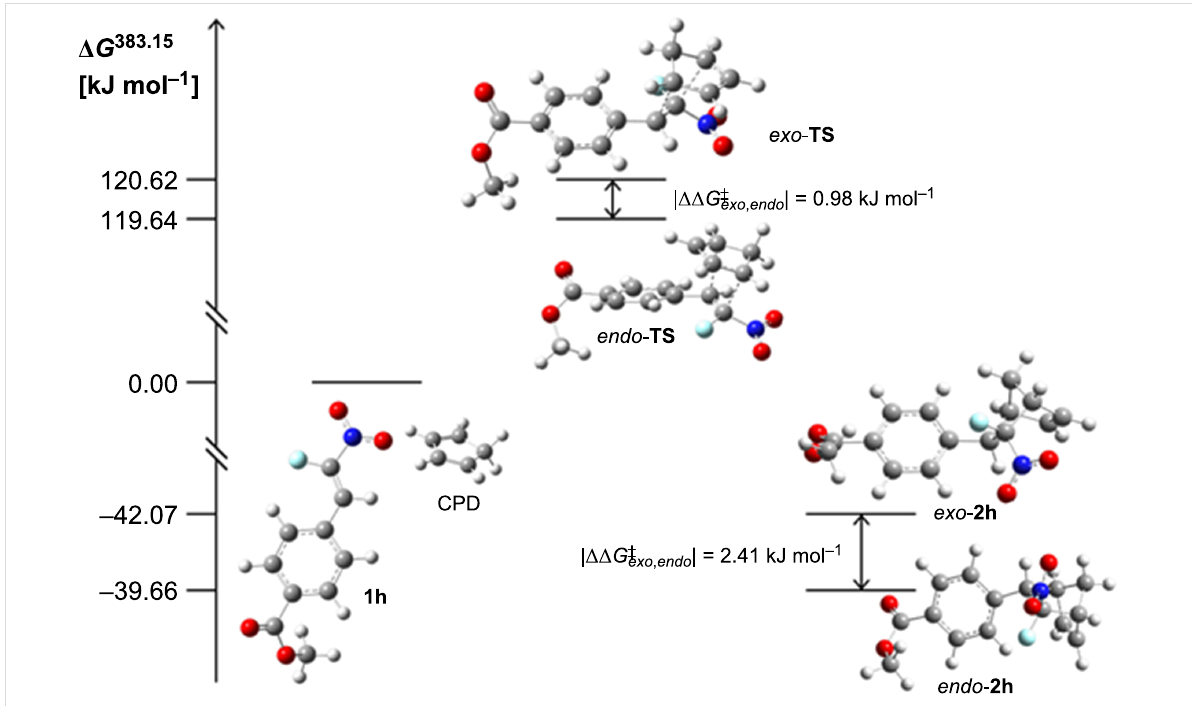
Figure 3: The predicted reaction pathway for the Diels–Alder reaction of nitrostyrene 1h with CPD is displayed. The path leading to the endo- 2h isomer has a lower lying transition state and is more exergonic than the path resulting in the exo- 2h isomer. Energies are given in kJ mol − 1 and were calculated with M062X/6-311+G(d,p) at 383.15 K in o -xylene (the corresponding B3LYP reaction pathway is not